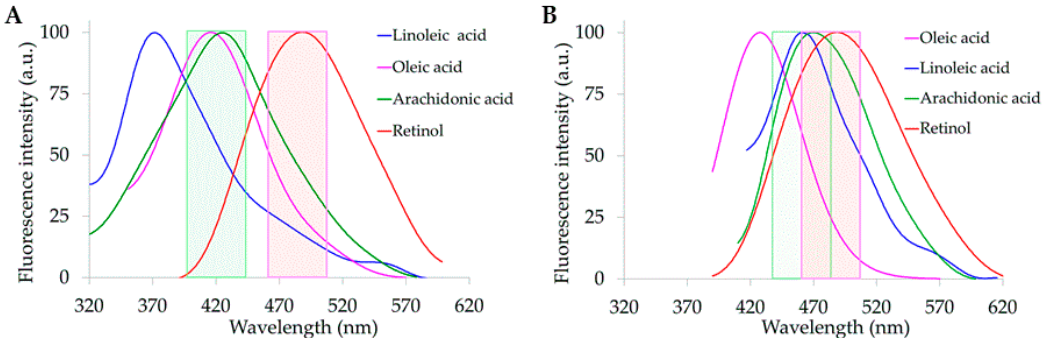
Figure 3. Emission spectra of pure compounds in ethanol solution (100%), excited at 310 nm ( A ) or 366 nm ( B ). Concentrations are reported in the Figure 1 caption. Spectra are normalized to the maximum peak value. Compounds are indicated by colors, on the right.